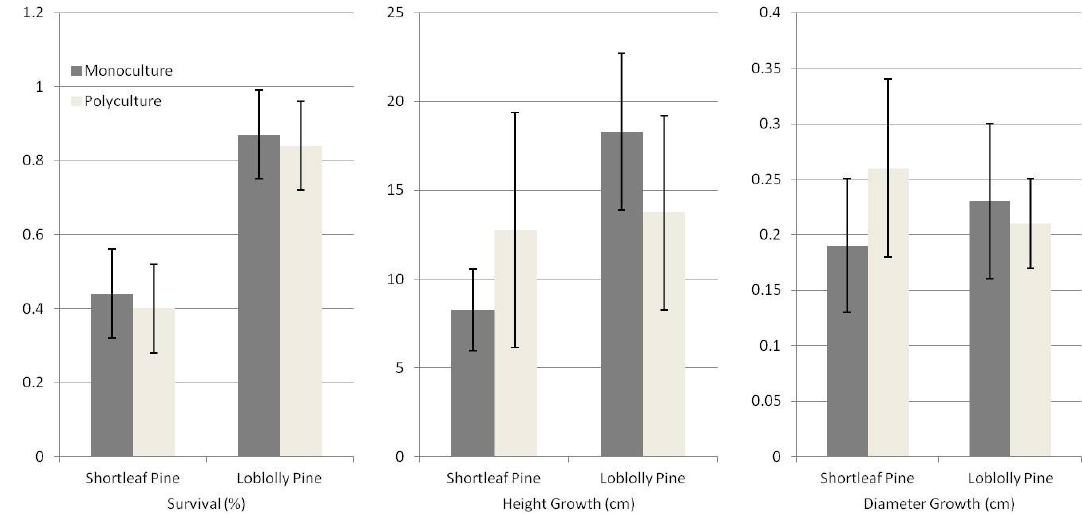
Figure 3. First-year growth and percent survival of shortleaf pine and loblolly pine planted in pine monoculture and pine-hardwood polyculture on rehabilitated legacy mine land in eastern Kentucky.